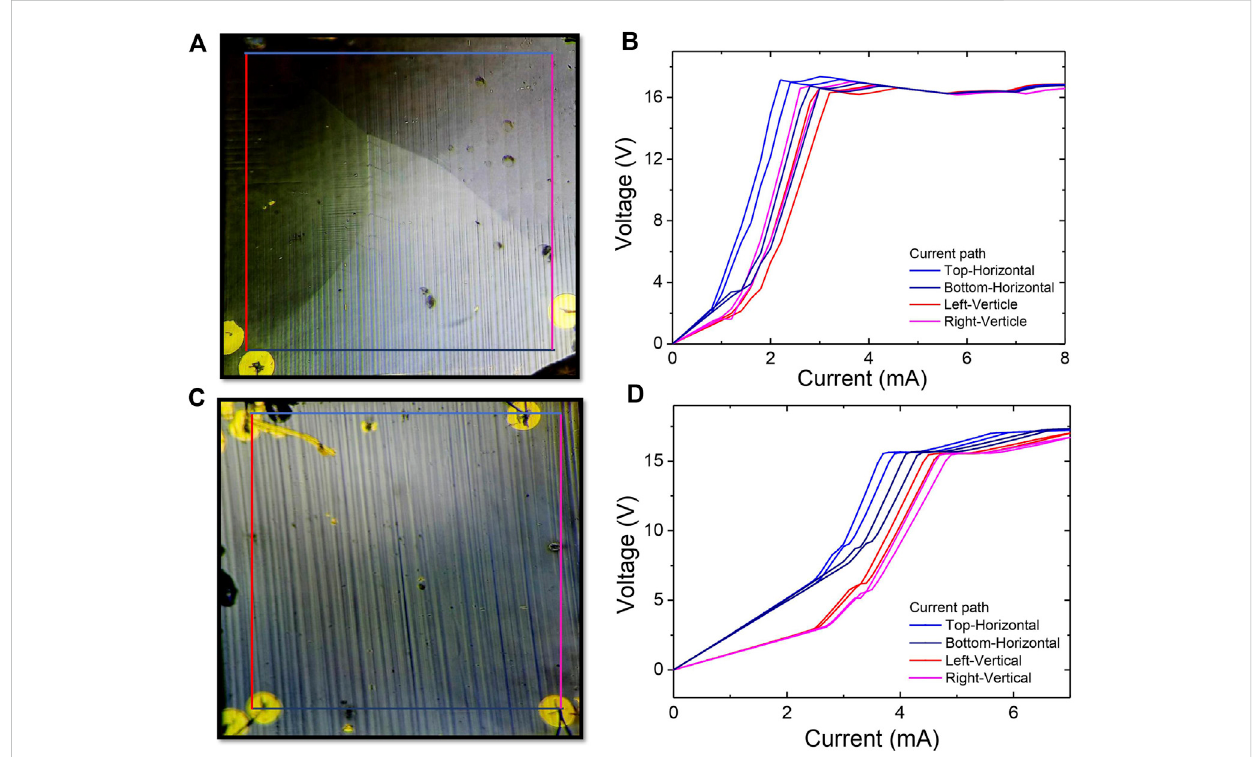
FIGURE 4 OpticalmicroscopicimageofanLSMOthin fi lmgrownona5 mm×5 mm (A) inhomogeneouslydistributedverticalandhorizontaltwinneddomain LAO substrate and (C) homogeneously distributed twinned domains along the vertical direction of the LAO substrate. The corresponding current vs voltage sweeps of (A) and (C) at 300 K are shown in (B) and (D)